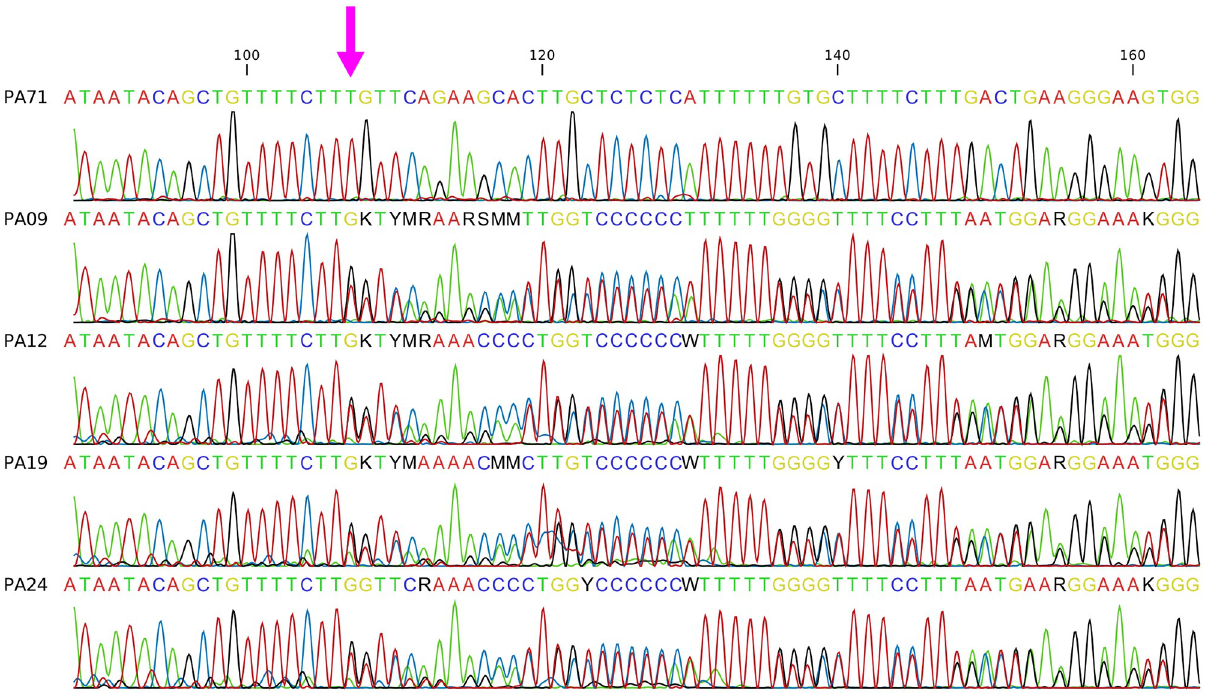
Fig 3. Electropherograms of the intron 1 of the SOD1 gene region harboring the newly identified ENSCAFG00000008859:g.26540247del. A pink arrow is highlighting the deletion position. The first individual (PA71) is homozygous “TT” and used as a reference. The second to fifth individuals (PA09, PA12, PA19, and PA24) are “T-” heterozygous individuals.